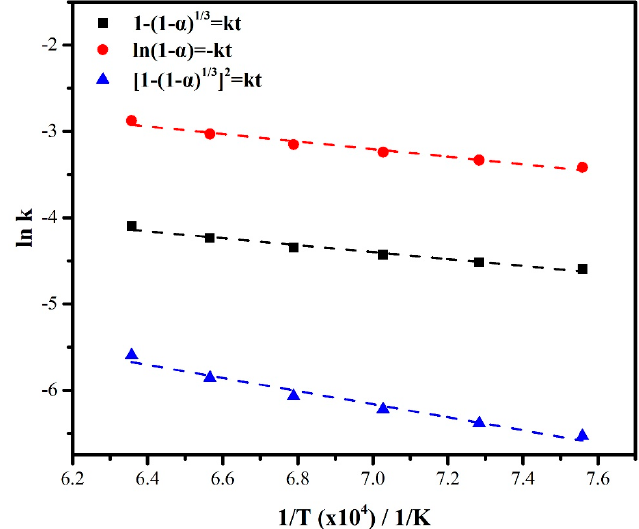
Figure 14. The linear fitting of the Arrhenius Equation of various kinetic models (Equations (2)–(4)). Table 6. The fitting parameters of the Arrhenius Equation of various kinetic models (Equations (2)–(4)).